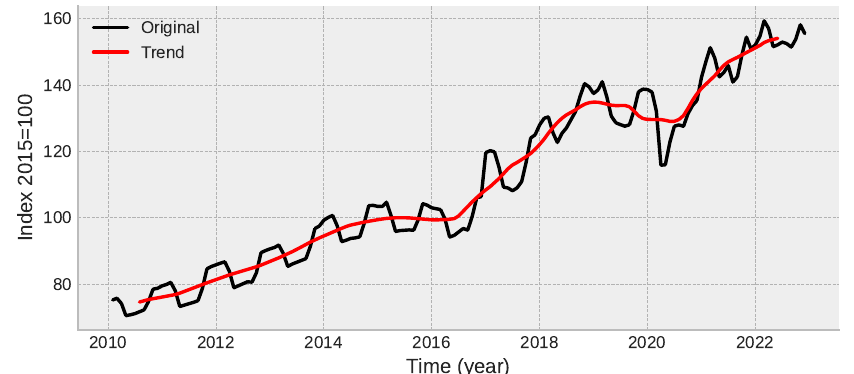
Figure 2. Original signal and its trend given by the SDMA